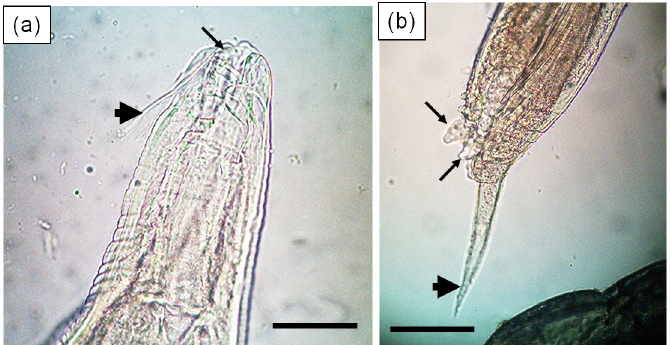
Fig 5. Photomicrographs of a male Labiduris sp. nematode detected in a Galápagos giant tortoise faecal sample. Scale bars = 50 μ m. (a) Anterior end showing the subventral lips (arrow) with a posteriorly- directed fringe along the median edge (arrowhead). (b) Posterior end showing terminal appendix (arrowhead) and ventro-lateral papillae